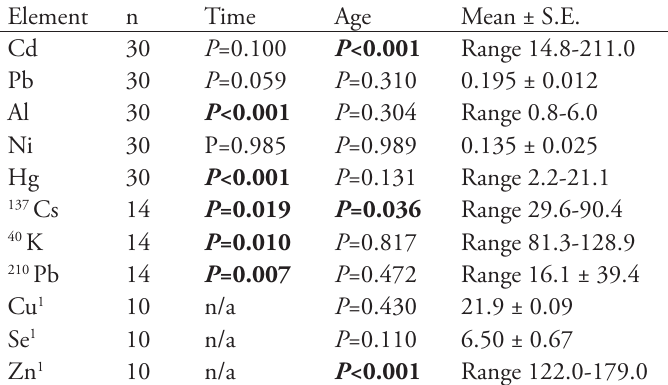
Table 1. The effect of time and age on various heavy metal (1994/95 versus 2000/01) and radionuclide (1993/94 versus 2000/01) concentra- tions found in the kidneys of Cape Bathurst barren-ground caribou. Mean (arithmetic for heavy metals, geometric for radionuclides) and S.E. are provided where no significant factor effect. Concentration of heavy metals reported as μg g -1 dry weight and radionuclides as Bq kg -1 wet weight. Bold indicates significance ( P